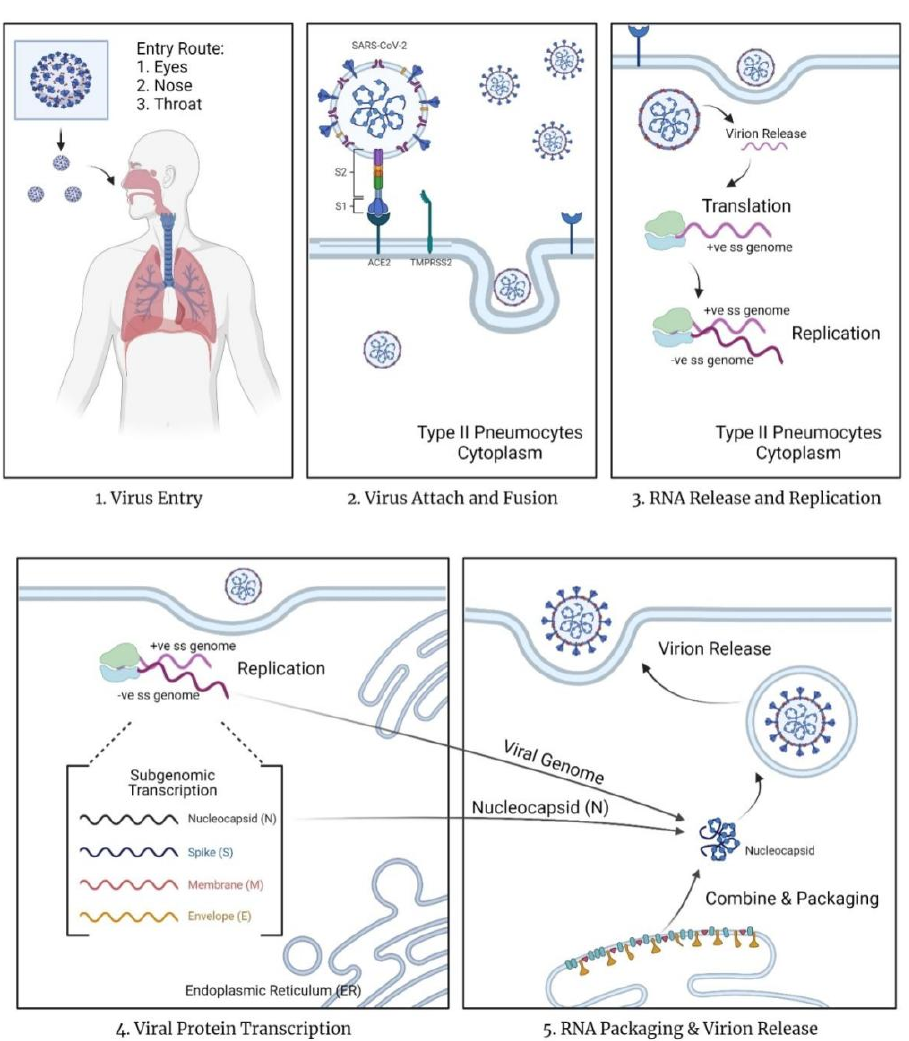
Figure 1. The mechanism of entry and replication of coronavirus diseases 2019 in host cells. Created with BioRender.com.